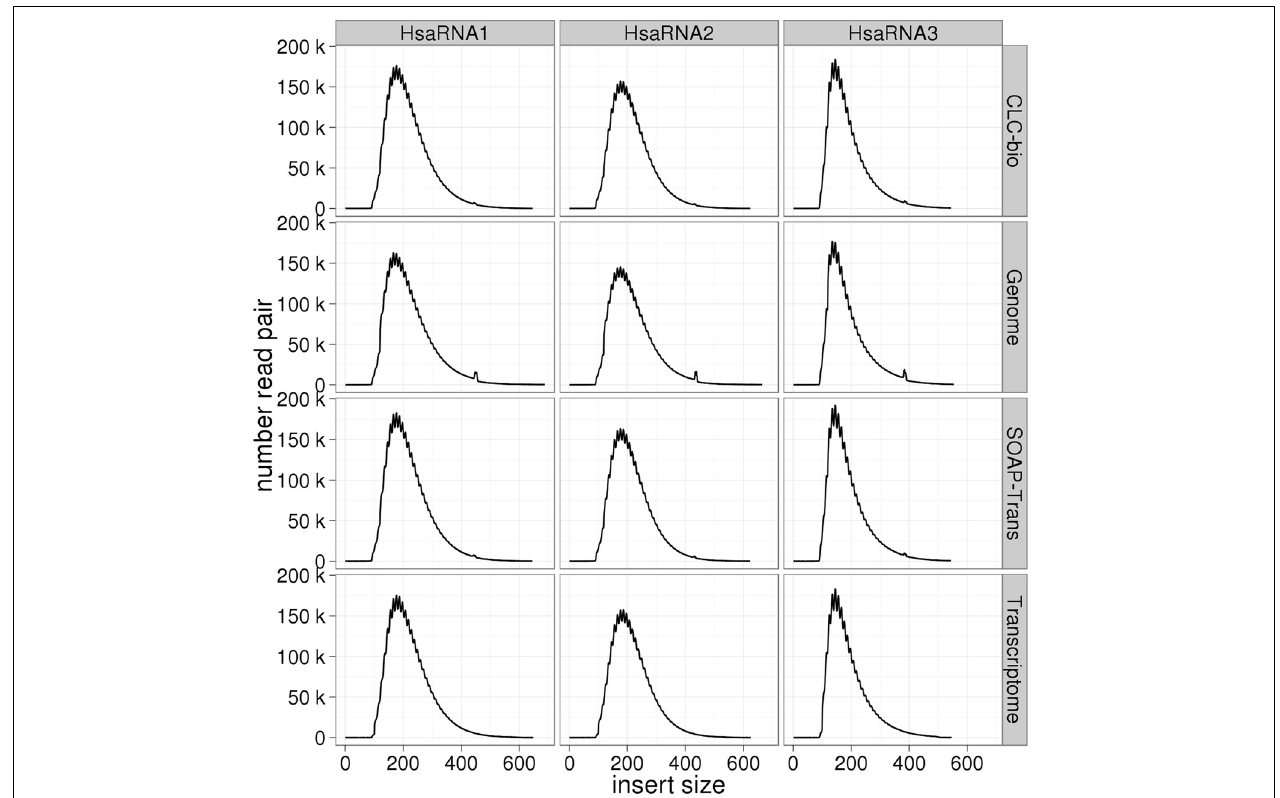
FIGURE 7 | Estimation of insert sizes for the human transcriptome libraries. Insert sizes are plotted for each replicate library using reads mapped against H. sapiens reference genome and transcriptome, CLC, and SOAPdenovo2 assemblies.